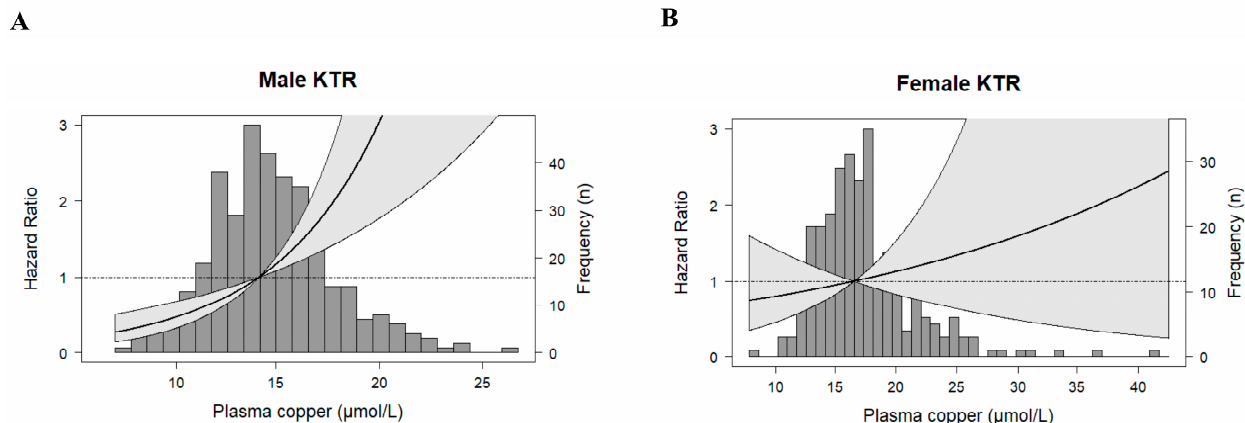
Figure 2. Sex-stratified analyses of the associations between plasma copper concentration and cardiovascular mortality in KTR. Male ( A ) and female ( B ) KTR data were fitted using a cubic spline- based Cox proportional-hazards regression model. The reference value was the median plasma copper concentration of 14.64 µ mol/L for males ( A ), and 16.68 µ mol/L for females ( B ). The solid line represents the hazard ratio. The grey area represents the 95% confidence interval. KTR, kidney transplant recipients.